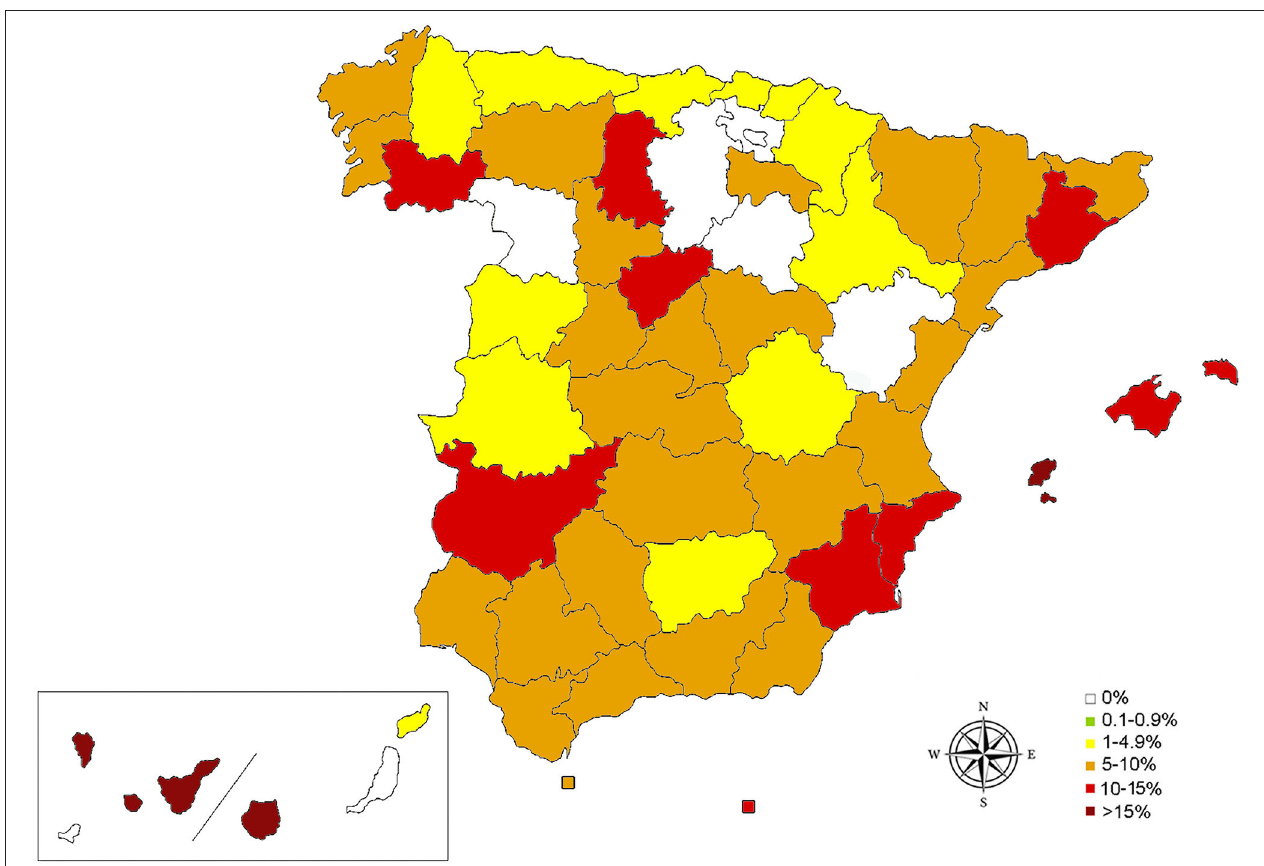
FIGURE 1 | Map of seroprevalences for D. immitis in cats in Spain by provinces, islands, and autonomous